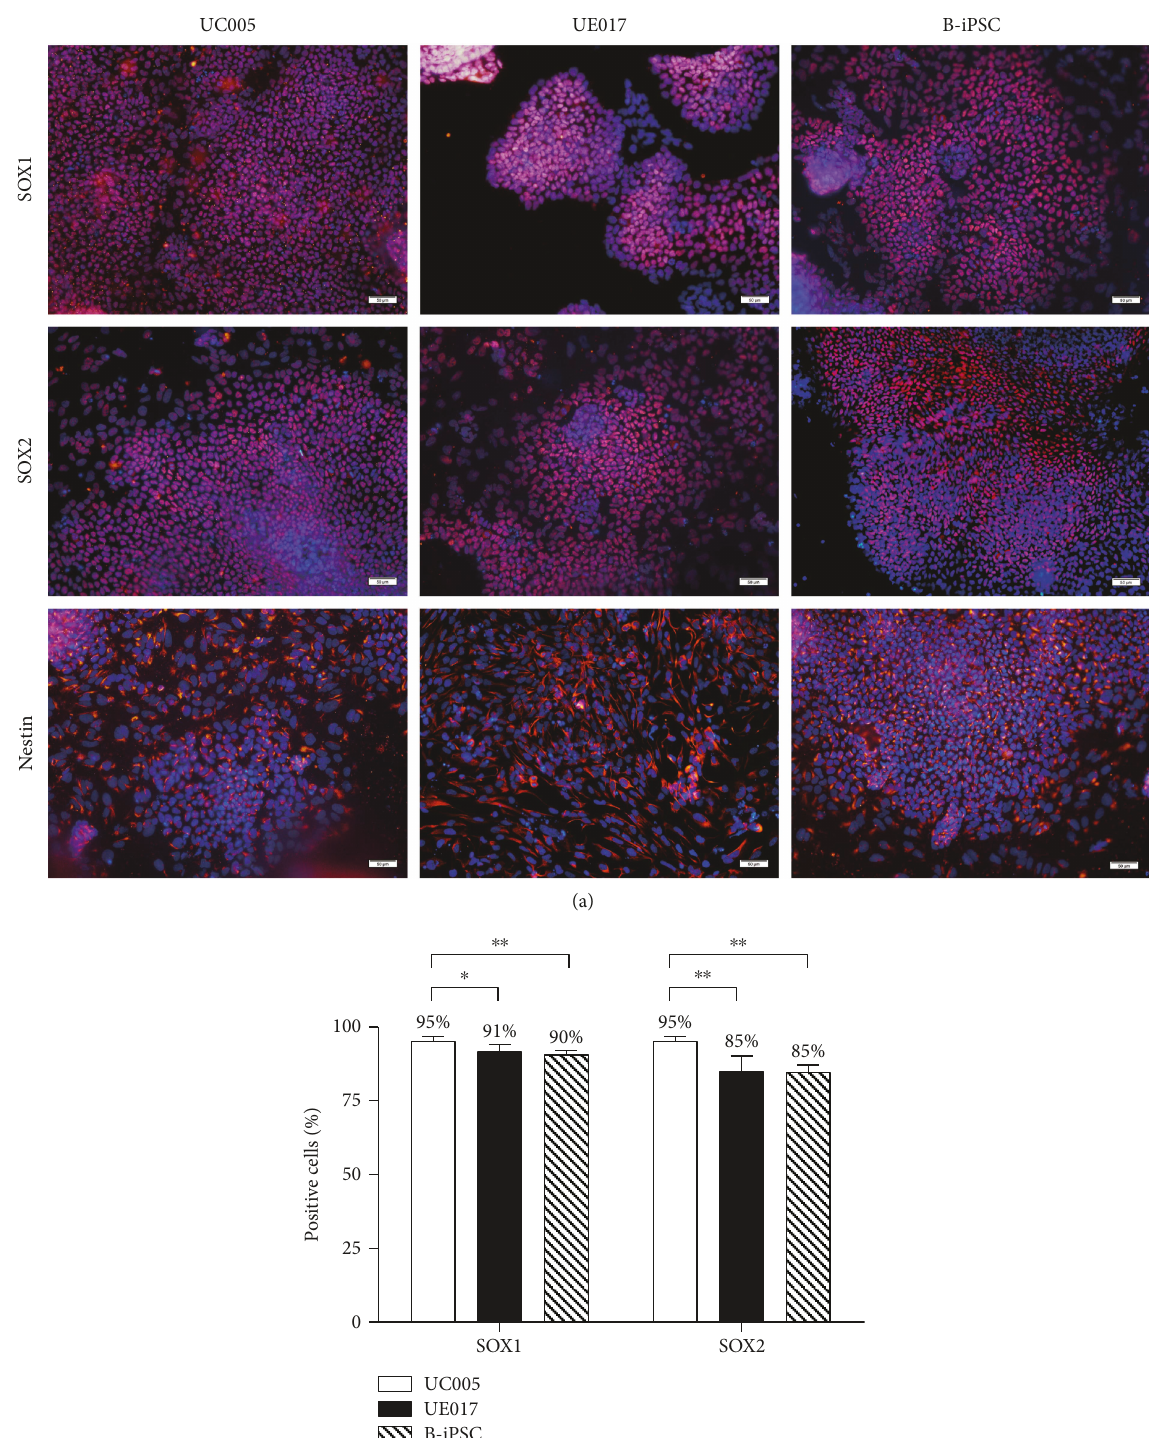
Figure 3: NEPs derived from urine-iPSCs and B-iPSCs express neural progenitor markers. (a) Immunocytochemical staining of neural progenitor markers. NEPs derived from all three iPSC lines, B-iPSC, UC005, and UE017, were positive for the neural precursor markers, SOX1, SOX2, and Nestin. Cell nuclei were counterstained with 4 ′ ,6-diamidino-2-phenylindole (DAPI). The scale bar is 50 μ m. (b) The ratio of positive labeling for SOX1 and SOX2 in NEPs after 7 days of induction. NEPs from UC005 expressed higher levels of neural precursor markers. The ratio of positive labeling (%)=(number of positive cells/total number) × 100%. The results from three independent experiments are presented as the means ± standard errors of the mean (SEM). ∗∗ P < 0 001 and ∗ P < 0 01 according to Student ’ s t